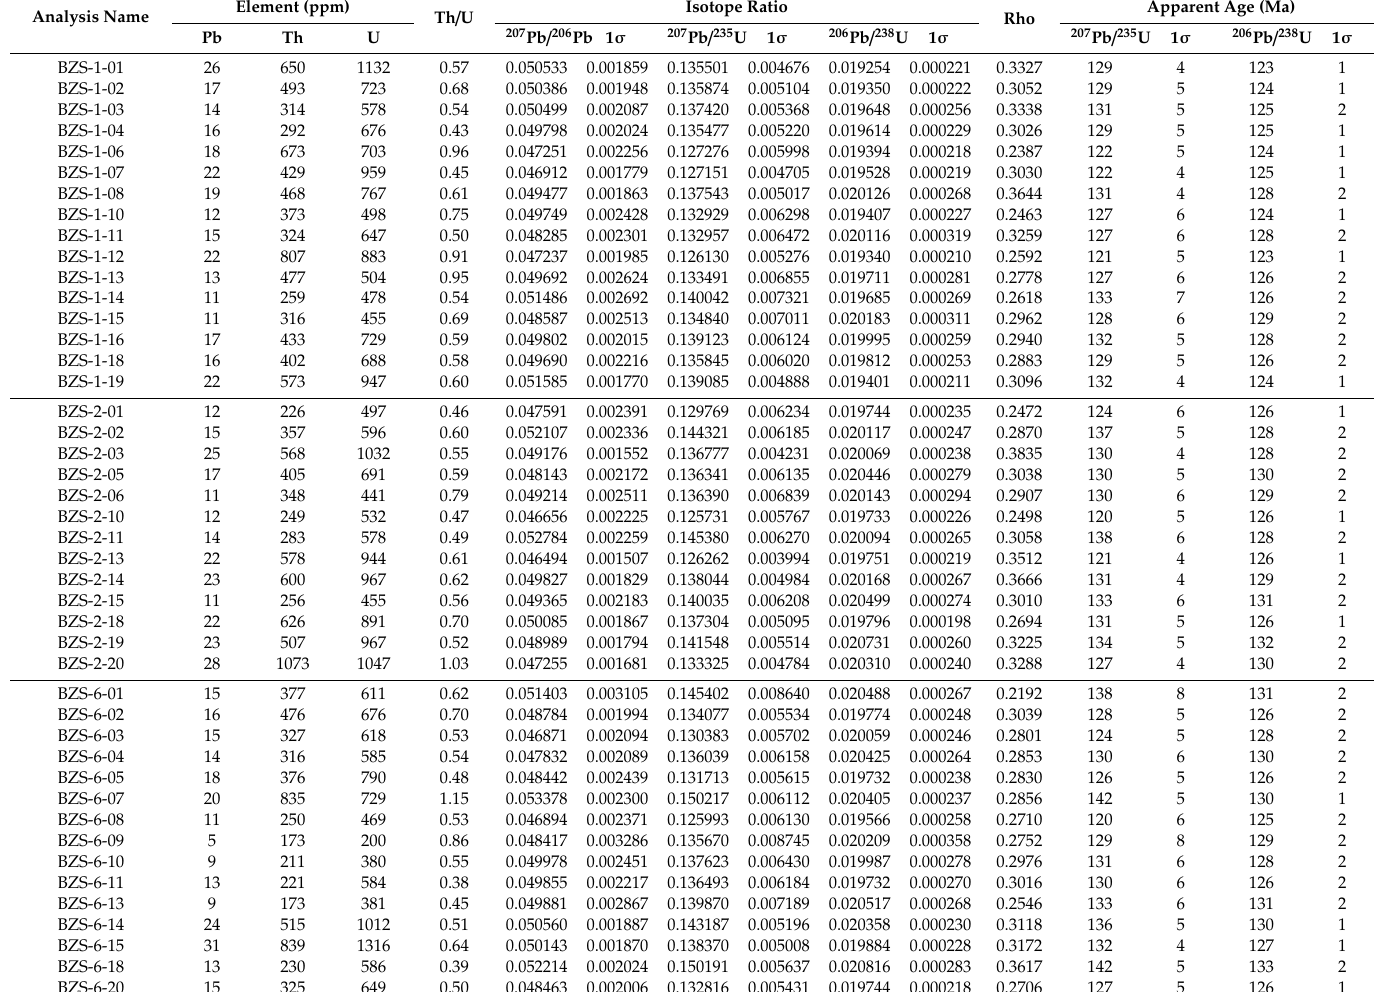
Table 2. In situ LA-ICP-MS zircon U-Pb isotope compositions for the Banzhusi granite